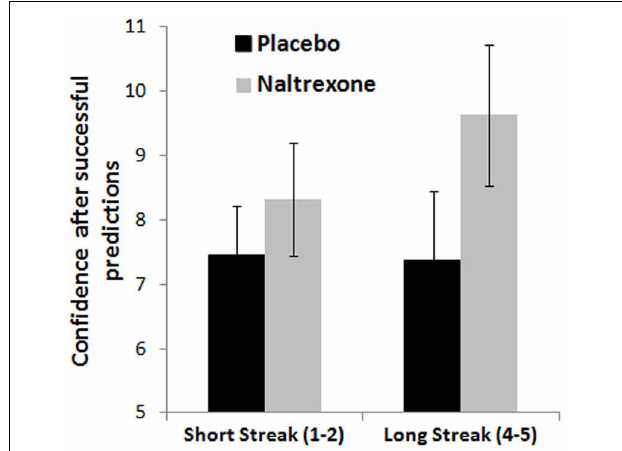
FIGURE 6 | Confidence ratings on the roulette task as a function of winning streak length show a marginal difference between the naltrexone and placebo groups. Error bars indicate standard error of the